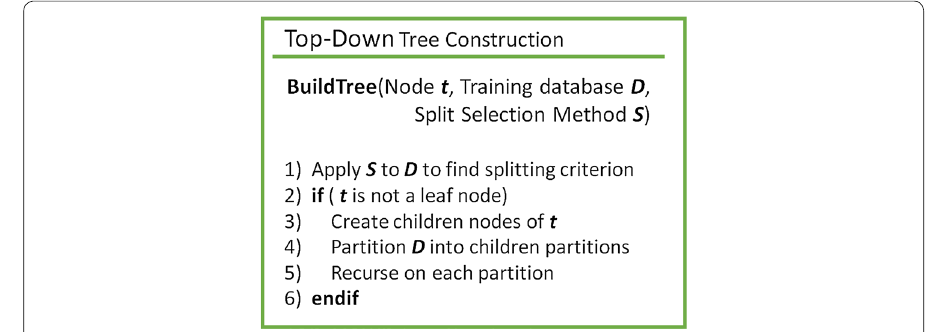
Fig. 1 Hunt’s Concept Learning System